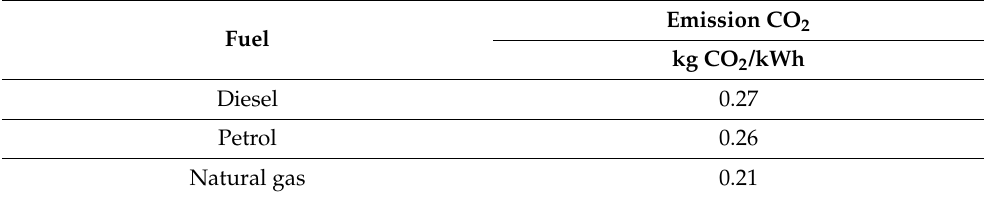
Table 2. Emission CO 2 from the combustion of selected fuels